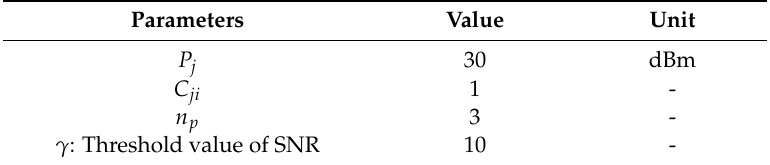
Table 1. The relevant parameters of the communication link model. SNR: signal-to-noise ratio.